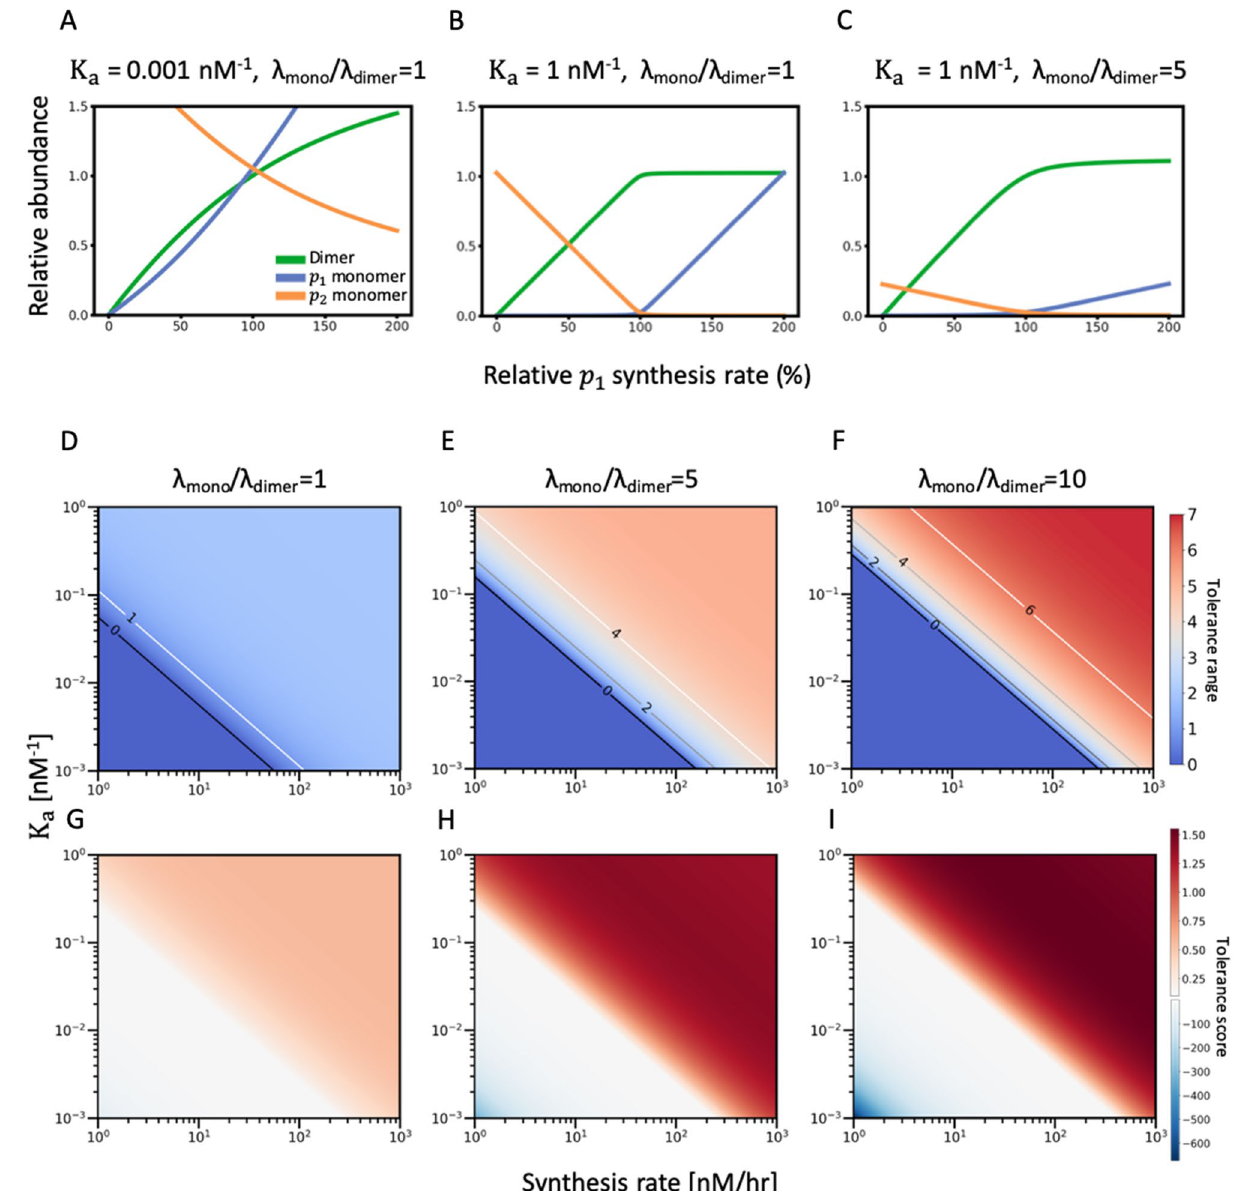
Figure 1. Cooperative stability allows protein complex formation systems to overcome systematic constraints on stoichiometric balance arising from synthesis rate variations. ( A – C ) For heterodimers, the abundance of each protein species—dimer p 3 (green), monomer p 1 (blue) and monomer p 2 (orange)—in response to synthesis rate variations is plotted. Protein abundance is normalized to dimer p 3 abundance ( C 1 = C 2 ). The p 2 synthesis rate C 2 is fixed at 50 nM/h and the p 1 synthesis rate C 1 varies from 0 to 100 nM/h (0–200% relative to the p 2 synthesis rate C 2 ). The response curves of each protein species in the absence of cooperative stability 1 0.001 nM 1 ) are plotted when the binding affinity is either ( A ) low ( K ( (cid:31) monomer / (cid:31) dimer ) or ( B ) high a = − = 1 1 nM 5 ) ( K a ). Response curves of each protein species subjected to cooperative stability ( (cid:31) monomer / (cid:31) dimer − = = 1 1 nM and with high binding affinity ( K a ) are shown in ( C ). ( D – F ). The heatmap of the tolerance range − = with parameter configurations in the physiological range. The x-axis is the reference protein synthesis rate ( C 2 ) from 1 to 1000 nM/h and the y-axis is the association constant K a from 0.001 to 1 nM −1 , both axes are at log scale. ( G – I ) The heatmap of the tolerance score within 0 to two-fold synthesis rate variation range in the same parameter space of K a and C 2 as ( D – F ). For heterodimers without cooperative stability, the heatmap is plotted in ( D and G ). For heterodimer with cooperative stability, the heatmaps are plotted for different extent of (cid:31) 5 ( E and H ) and (cid:31) 10 ( F and I differential degradation rate using (cid:31) monomer / (cid:31) dimer monomer / dimer = =